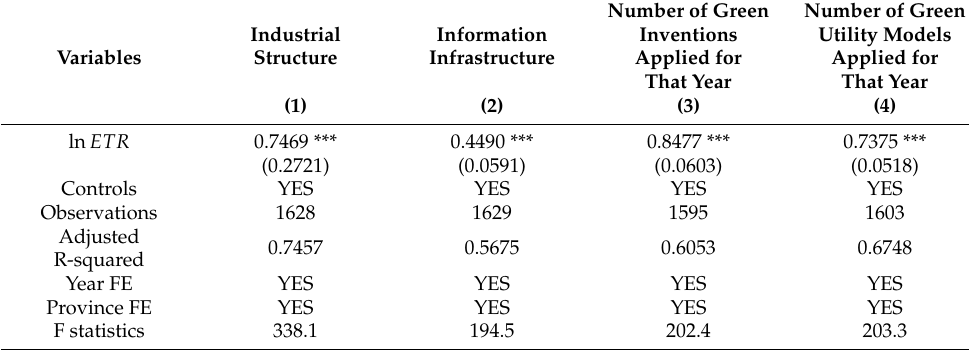
Table 8. Mechanism test: industrial structure effect.